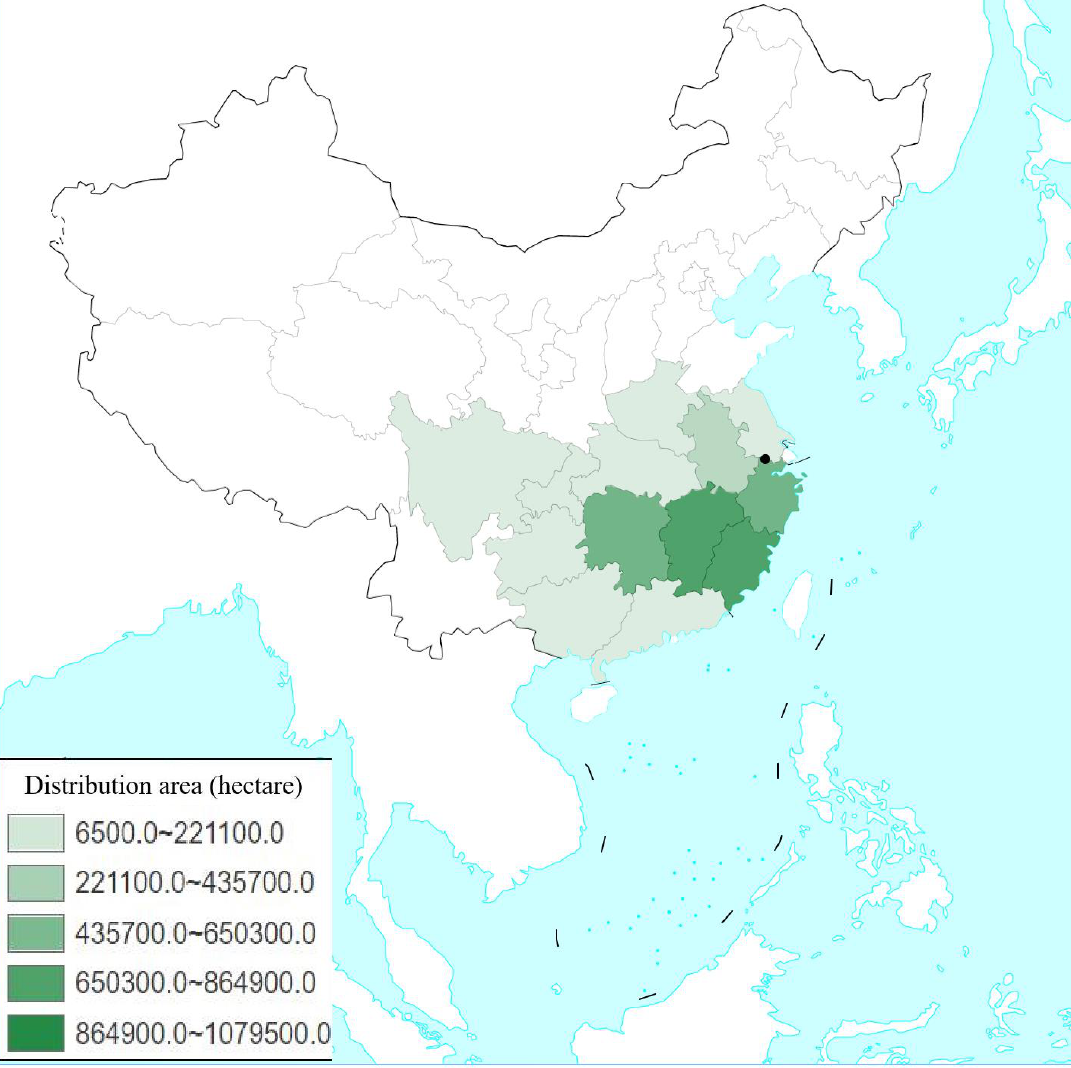
Figure 1. Distribution area (hectare) of Phyllostachys heterocycla in each province of China. The black spot represents the site of the hazard investigation of Hippotiscus dorsalis and climate data collection (Anji county, Huzhou City, Zhejiang Province, China). The data of moso bamboo distribution were based on the ninth national first class bamboo forest area, and the number of plants according to the forest species statistical table was downloaded from national forestry and grassland data center (http://www.forestdata.cn/index.html (accessed on 20 September 2020).